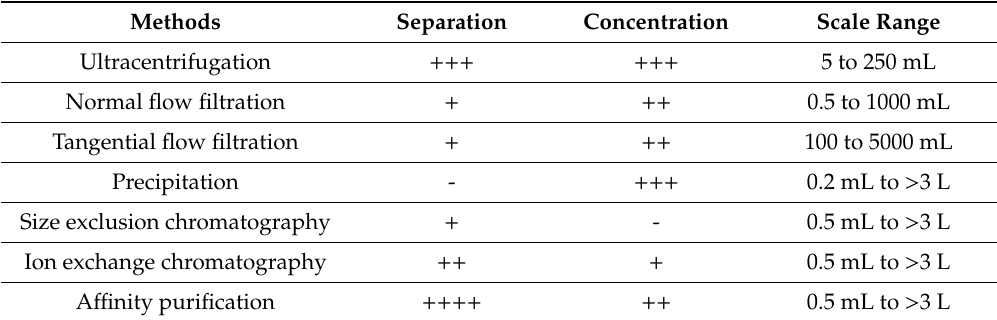
Table 1. Methods commonly used to purify virus and exosome are summarized based on their separation / concentration e ffi ciencies and scale